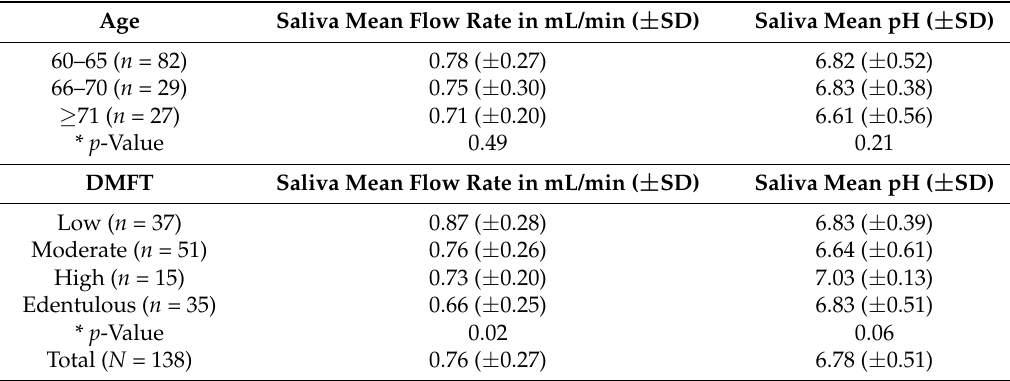
Table 3. Mean saliva flow rate and pH of saliva in relation to age and Decayed, Missed, Filled Teeth (DMFT) categories ( N =